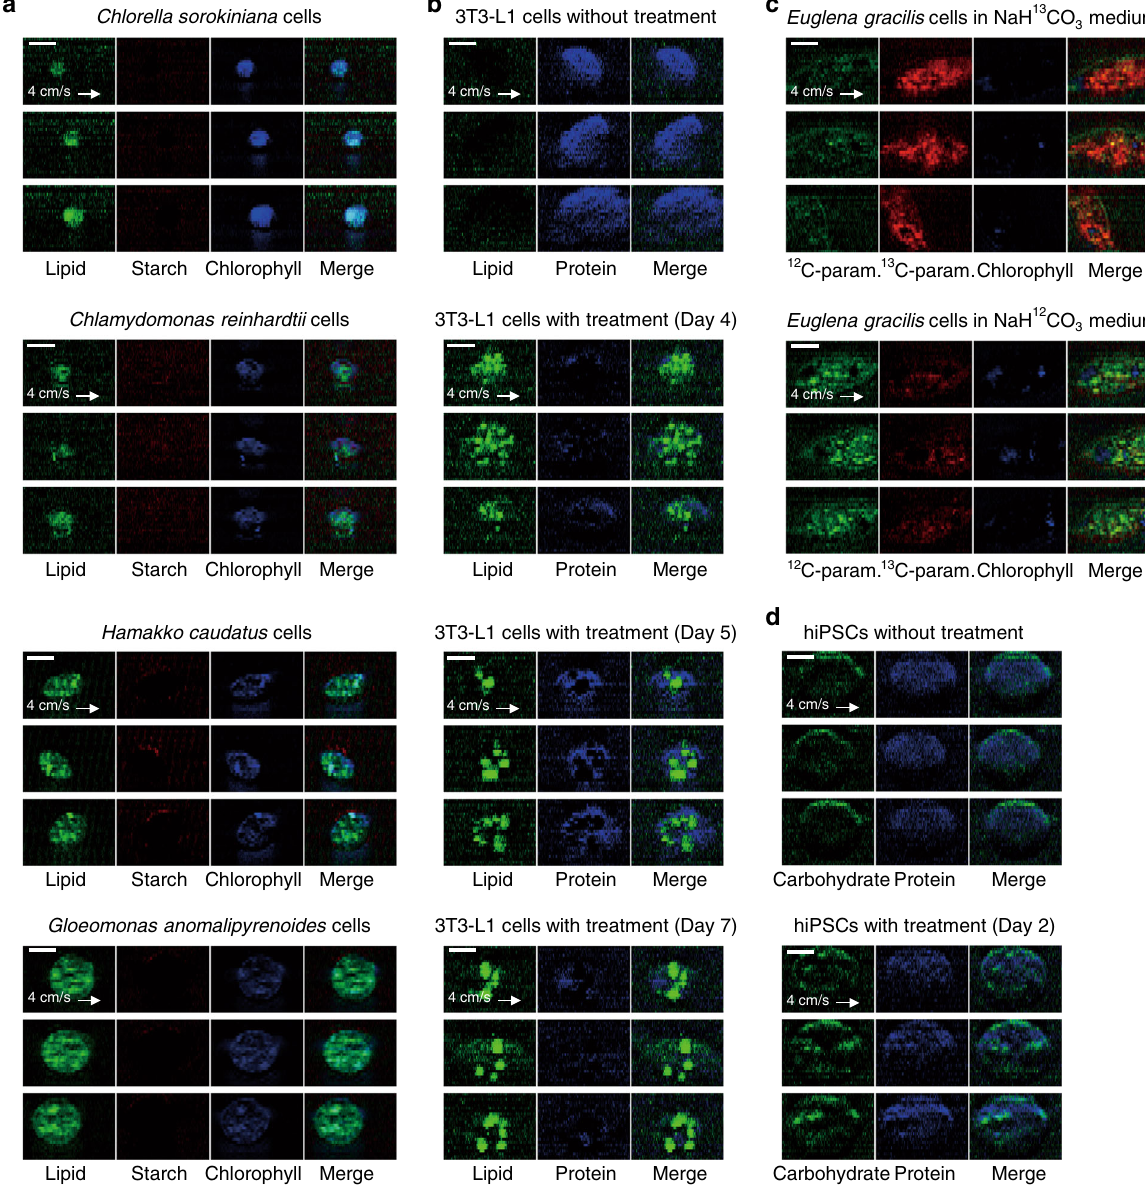
Fig. 3 Various types of cells imaged by the RIACS. Processing of the raw images was performed using ImageJ. Scale bars, 10 µ m. a SRS images of various microalgal cells whose size ranges from 3 to 20 µ m in cell diameter ( n = 10,348 for Chlorella sorokiniana cells, n = 12,236 for Chlamydomonas reinhardtii cells, n = 11,050 for Hamakko caudatus cells, and n = 12,793 for Gloeomonas anomalipyrenoides cells). b SRS images of 3T3-L1 cells that gradually accumulated lipids in the cytoplasm over 7 days of treatment for inducing their differentiation into adipocyte-like cells ( n = 11,159 for cells without treatment and n = 5,892, 10,359, and 10,114 for cells with 4, 5, and 7 days of treatment, respectively). c SRS images of Euglena gracilis cells with 12 C/ 13 C-isotope probing ( n = 5679 and 2075, respectively). d SRS images of hiPSCs cultivated in two different culture media for the naïve pluripotent state (with 2 days of treatment, n = 1699) and the primed pluripotent state (without treatment, n =